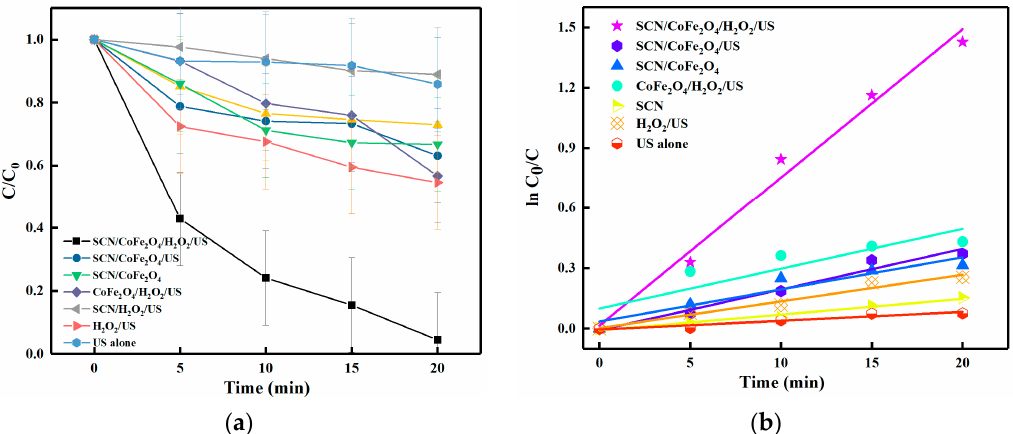
Figure 8. ( a ) Change in concentration of MB as a function of ultrasonication time; ( b ) ln(C 0 /C) versus ultrasonication time. Experimental conditions: [MB] = 25 ppm, [sonocatalyst] = 1 g/L, [H 2 O 2 ] = 4 vol %.